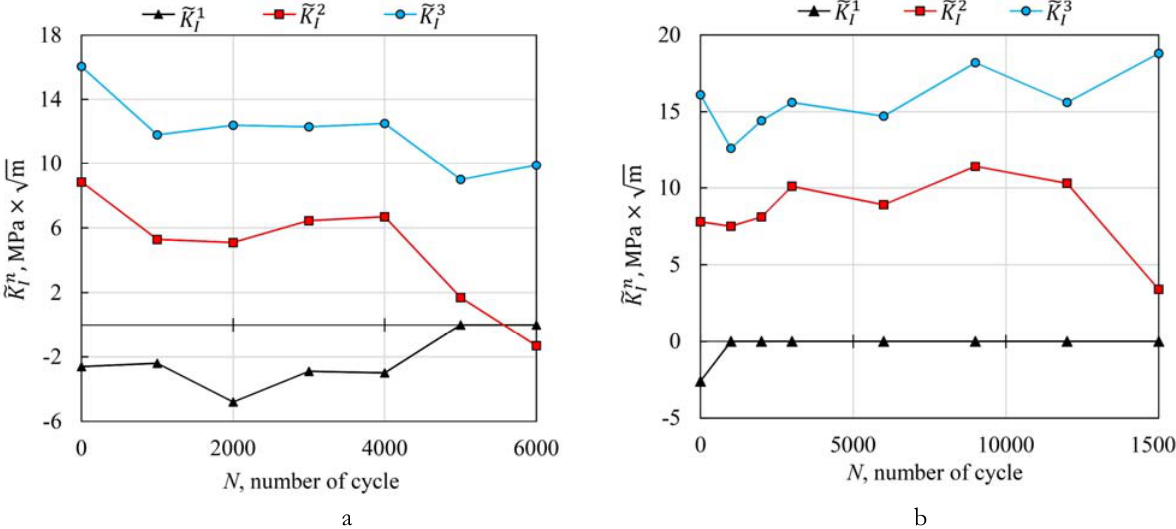
K values as a function of loading cycle number N for T5-H1 (a) and T5-H2 (b) specimens for notches of Figure 7: Residual SIF  n I a (n =1, 2, 3). length  n